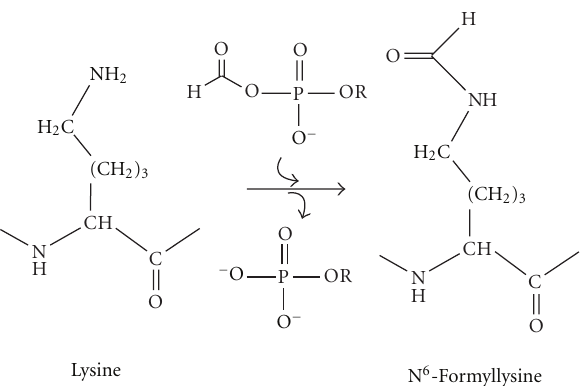
Figure 9: Lysine N-formylation by 3 (cid:3) -formylphosphate from 5 (cid:3) - oxidation of